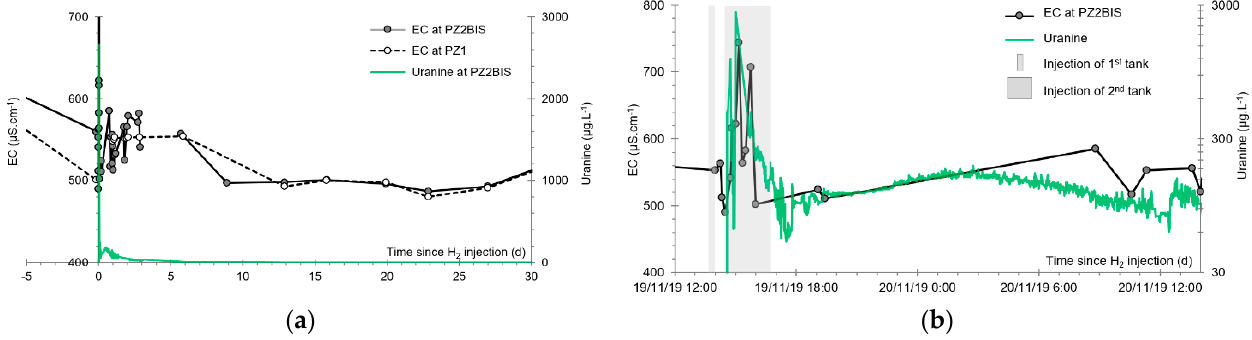
Figure 20. Comparative evolution of the electrical conductivity (EC) and the tracer concentration at PZ1 (20 m upstream)